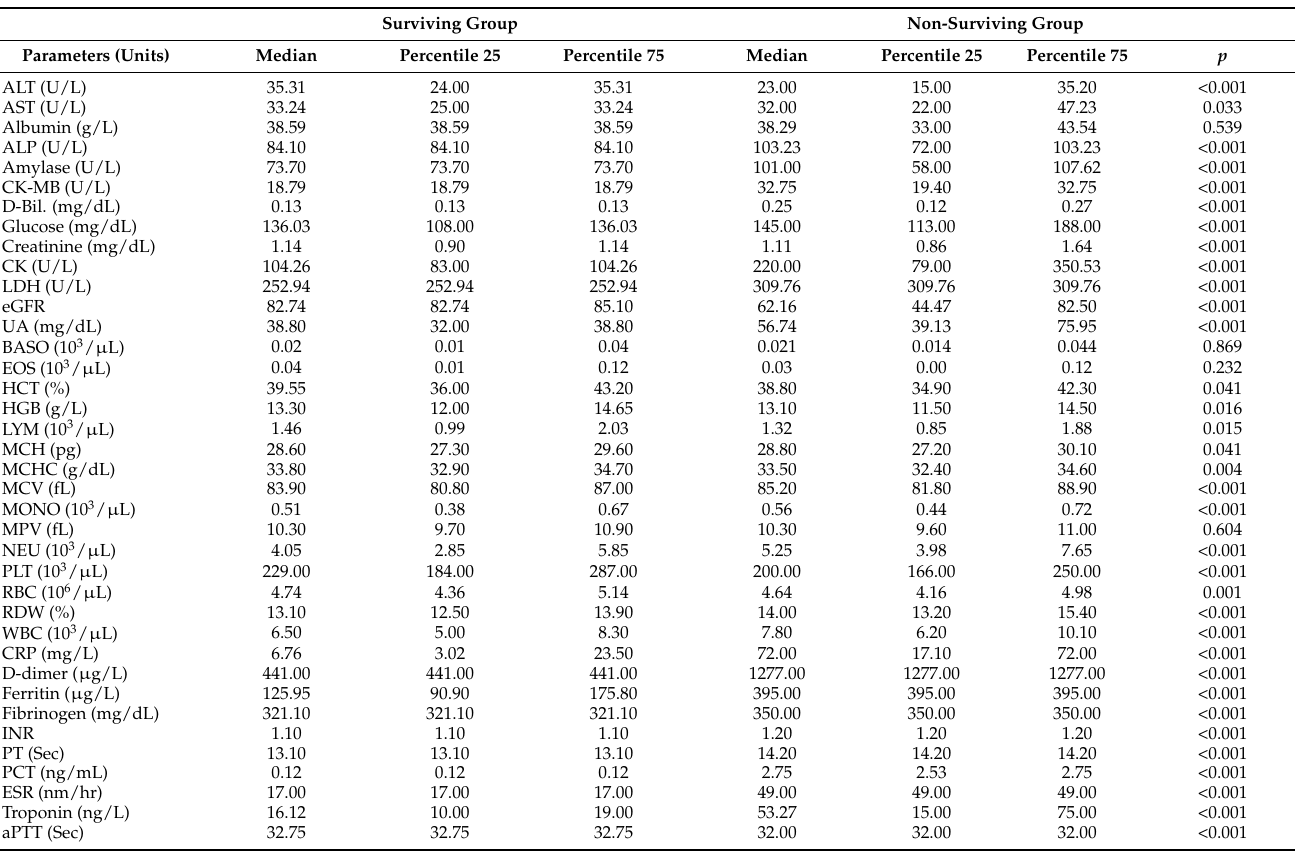
Table 3. Descriptive statistics of RBV values of surviving and non-surviving COVID-19